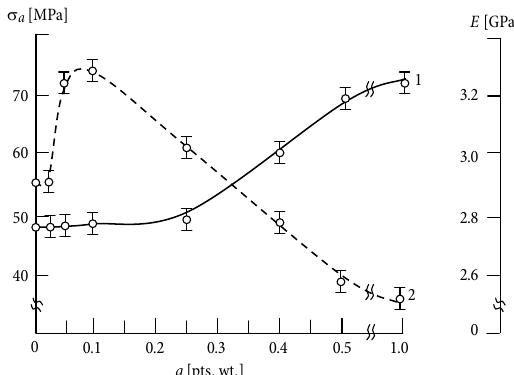
Fig. 3. Dependence of physical and mechanical properties of the matrix on the MMSCO content: curve 1 – fracture stresses in bending σ b ; curve 2 – modulus of elasticity in bending